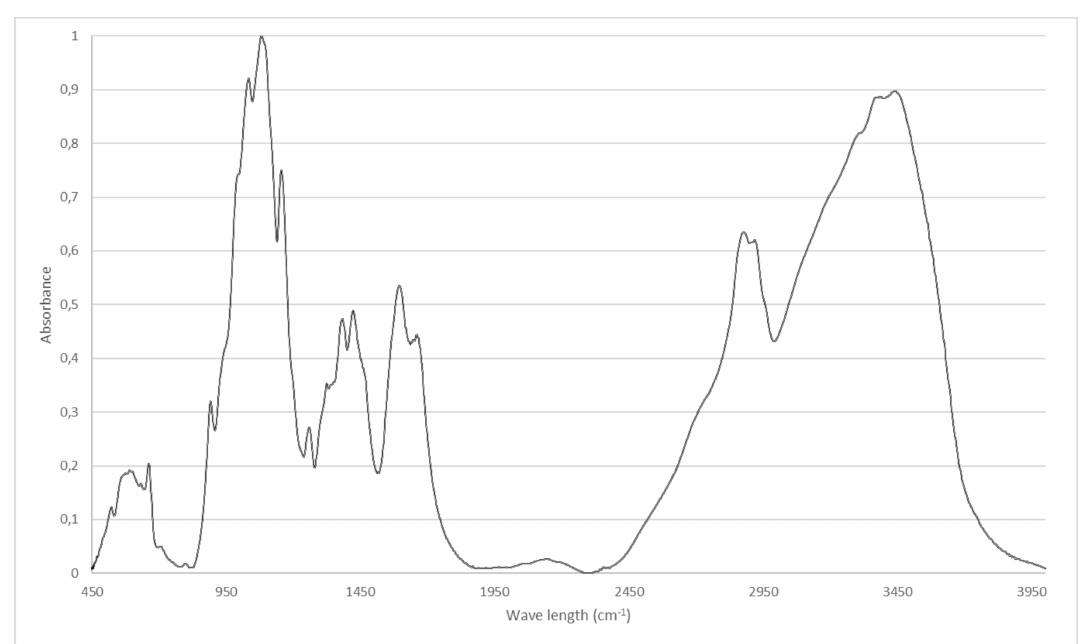
Figure 1. Infrared absorbtion spectra of produced COS BioA187.